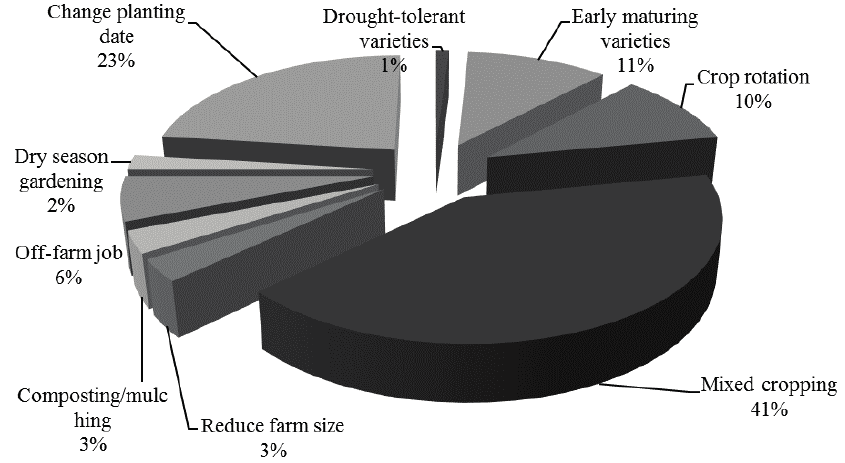
Figure 3. Actual adaptations being used by farmers in the Lawra district of